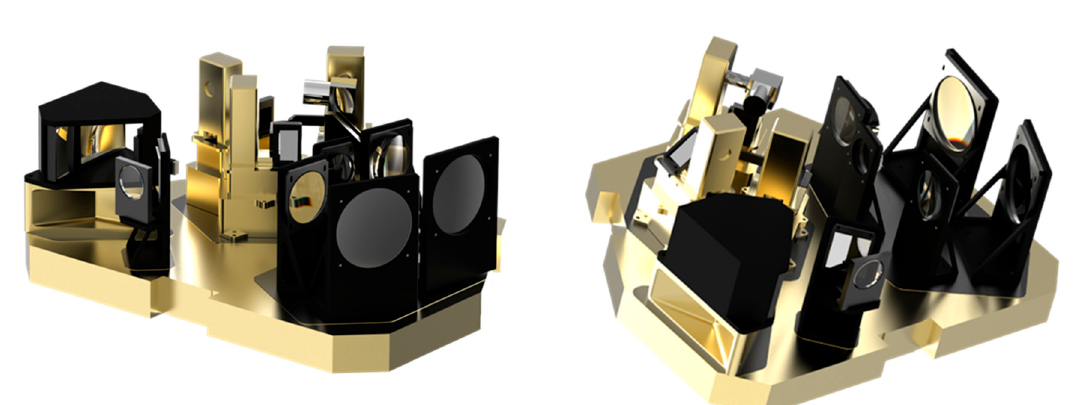
Figure 3. HIS on optical bench. Two views of an initial Surrey Satellite Technology Ltd (SSTL) concept design, which is subject to change as the mission undergoes detailed design during a formal Phase AB1.